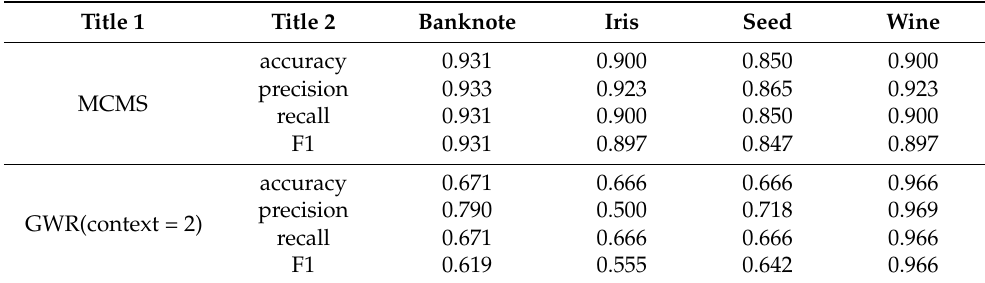
Table 2. Experimental results comparing the proposed MCMS and